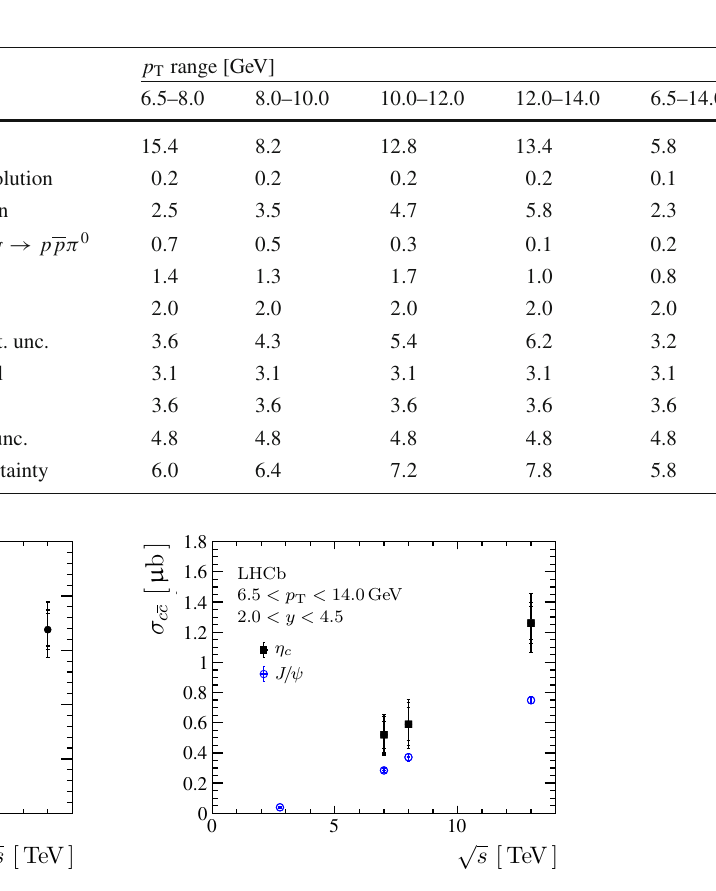
production cross-sections. The error bars show uncertainties due to sta- tistical, systematic, and to the η c → pp and J /ψ → pp branching fractions and J /ψ production